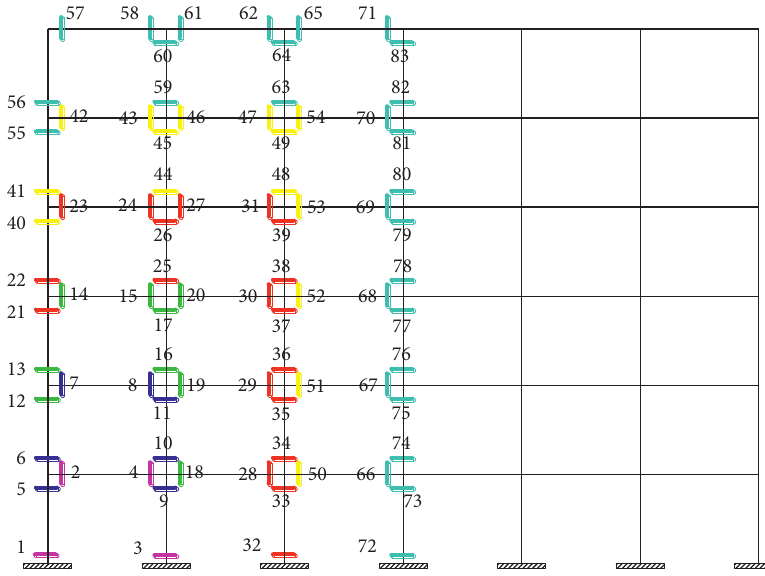
Figure 10: Renumbering of critical sections.